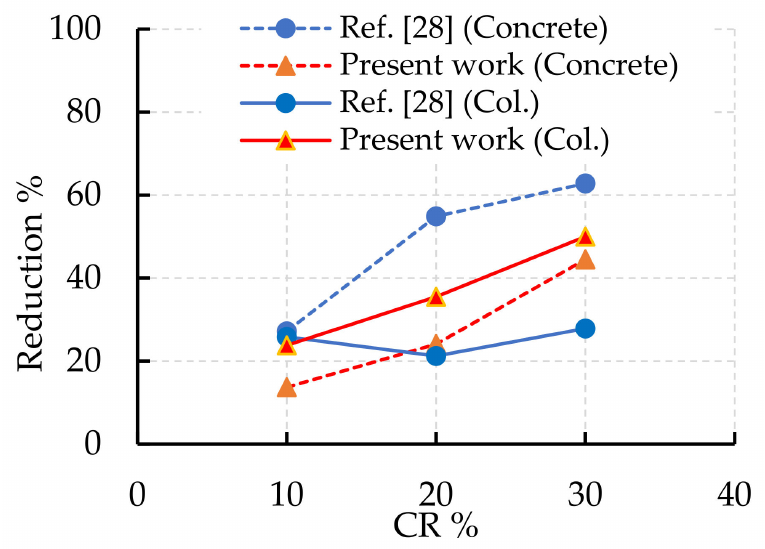
Figure 11. The effect of CR content on the concrete strength and column